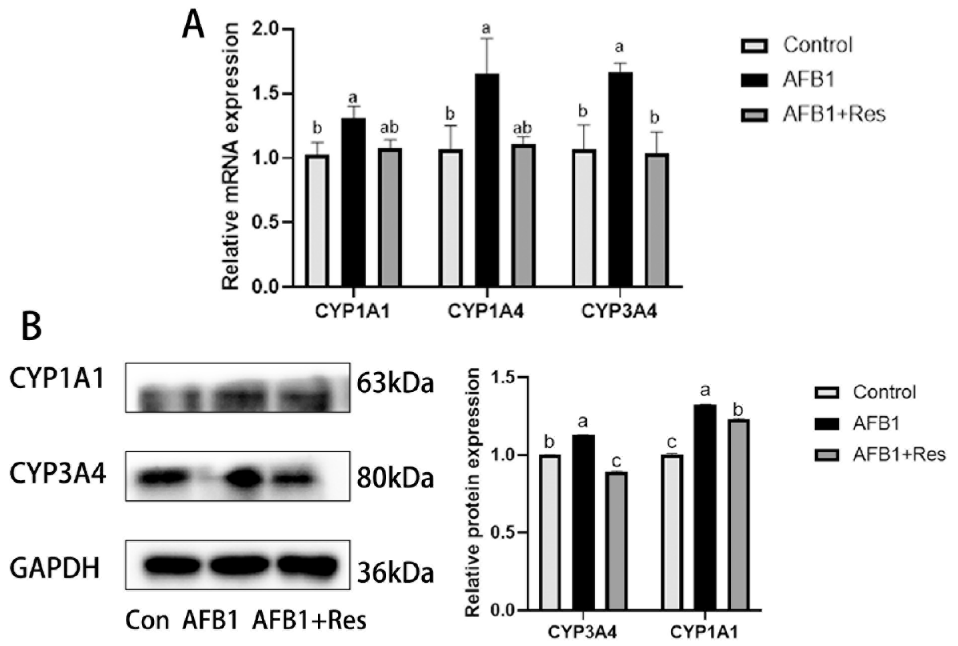
Figure 4. Expression of phase I metabolizing enzyme in the duck liver exposed to AFB1. ( A ): mRNA levels of the related genes of phase- I metabolic enzymes. ( B ): protein levels of the related genes of phase- I metabolic enzymes. Values are represented as the mean ± SEM ( n = 6). a–c Mean values with same superscript letters or no letters within a row were of no significant difference ( p > 0.05), those with different superscript letters were of significant or extremely significant difference ( p < 0.05).